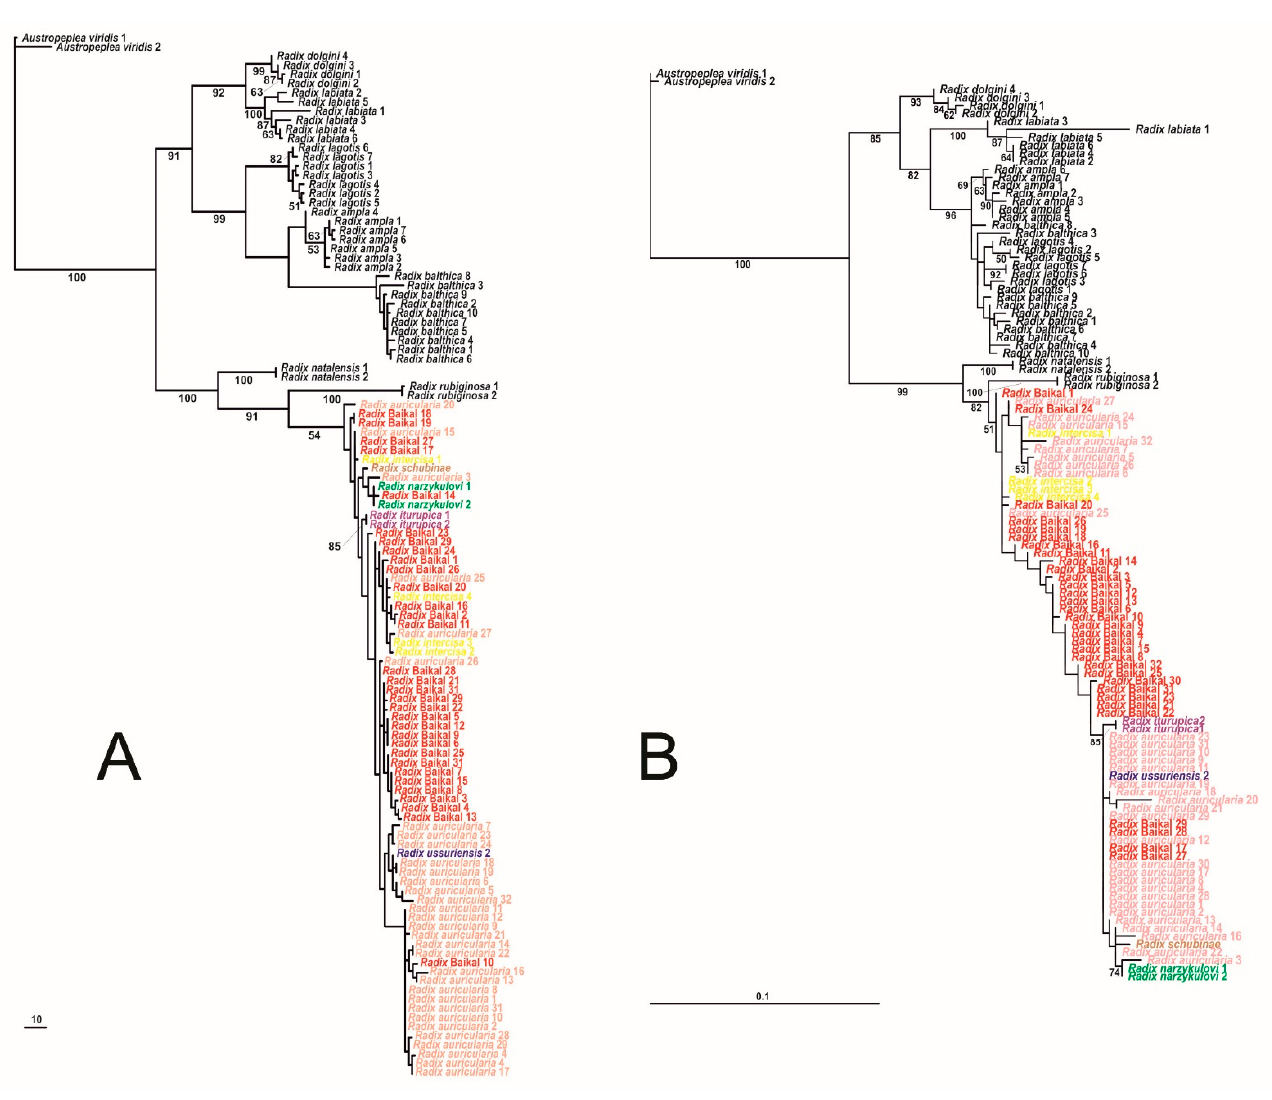
Figure 4. Hypotheses of the phylogenetic relationships of analysed Radix auricularia specimens based on the nuclear ITS-2 marker using different algorithms of tree building, ( A ) based on one of the 10,000 best MP trees (tree length = 618, CI = 0.7330, RI = 0.9634) and ( B ) based on RAxML. Branch lengths are proportional to the number of substitutions and the overall topology corresponds to that of the strict consensus tree. Bootstrap support values above 50% are reported below nodes.